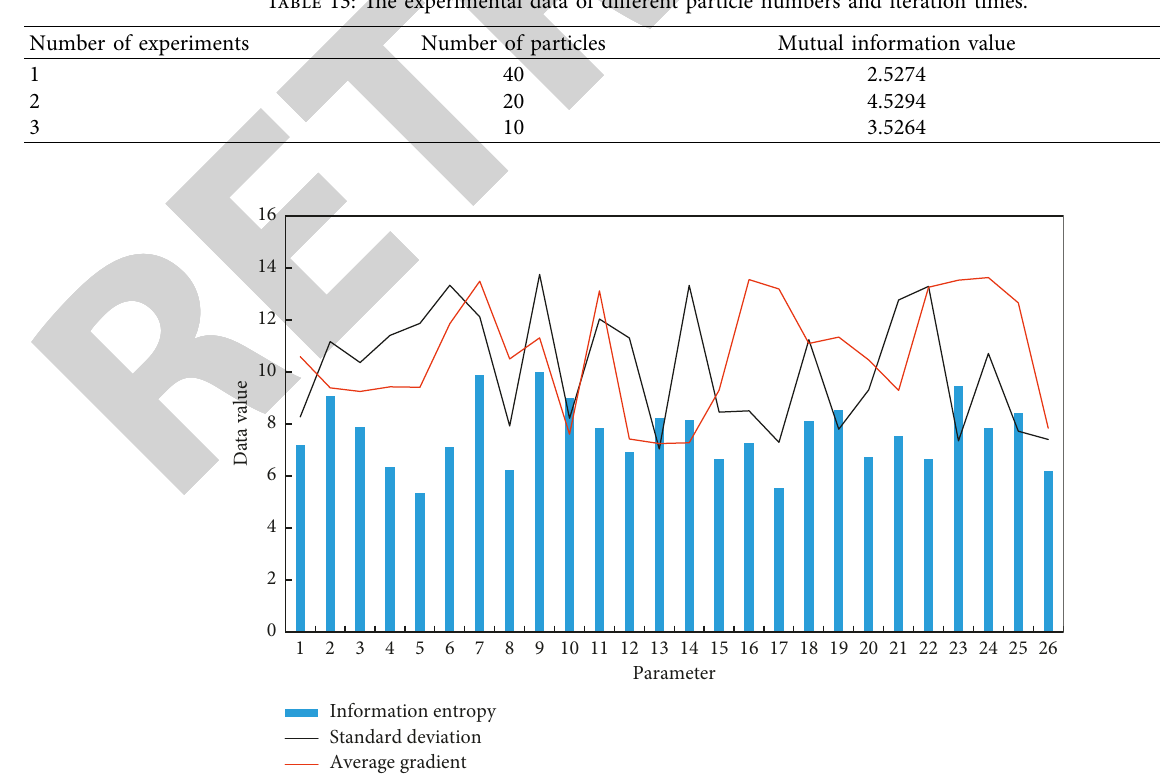
Figure 10: The TRE when the picture rotates and translates. Table 13: The experimental data of different particle numbers and iteration times.